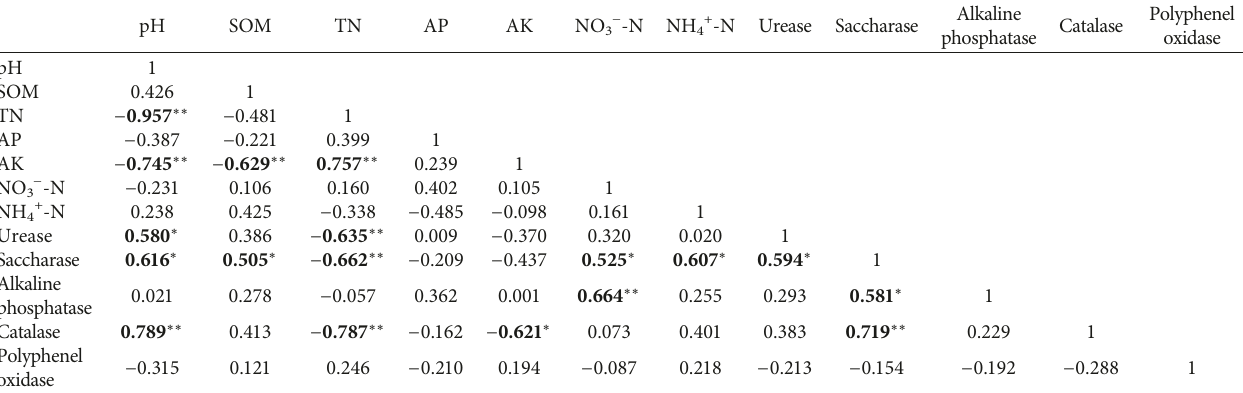
Table 6: Pearson correlation matrix among soil physicochemical properties and soil enzyme activities.